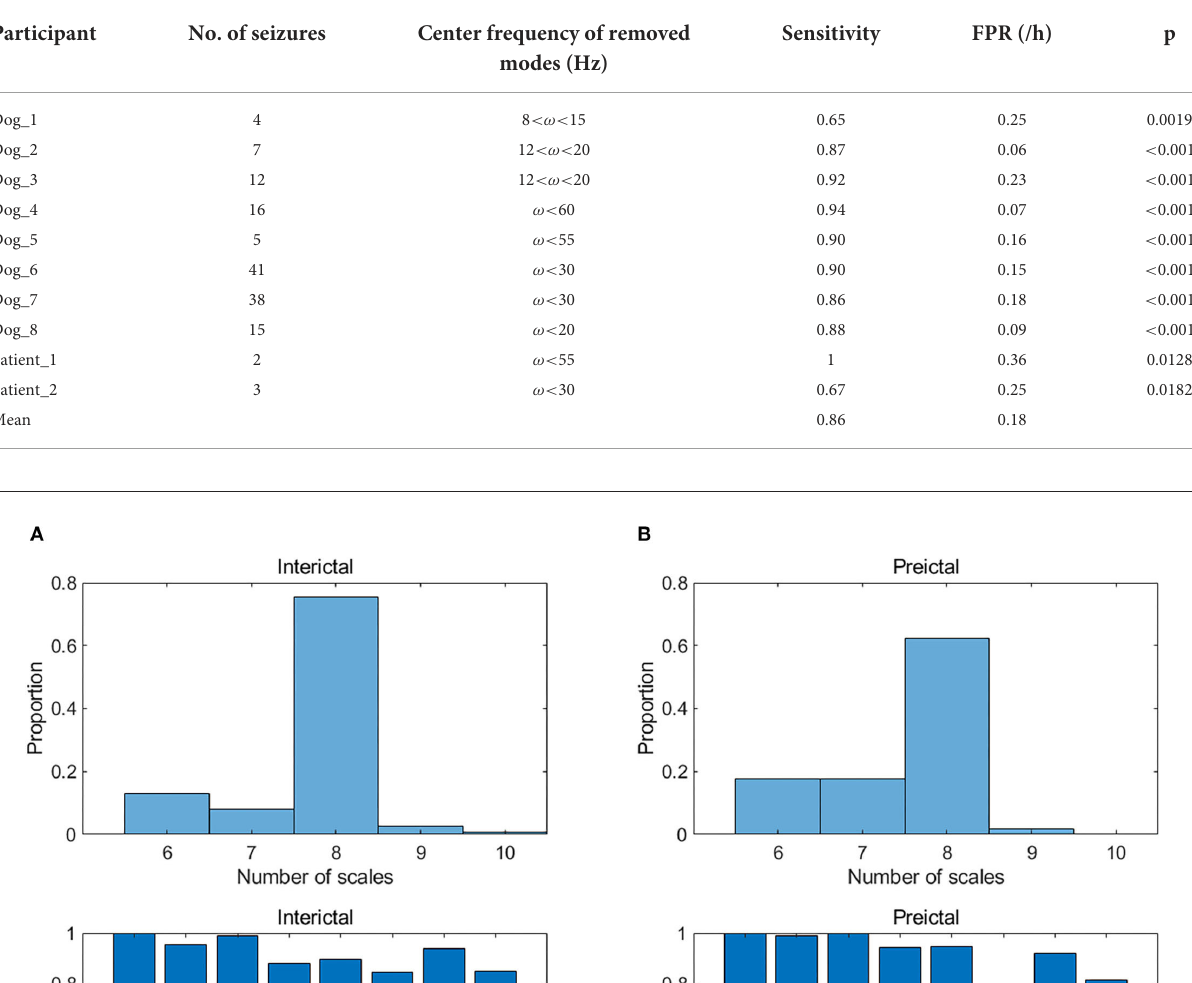
TABLE 3 The performance of the proposed method on 10 subjects.